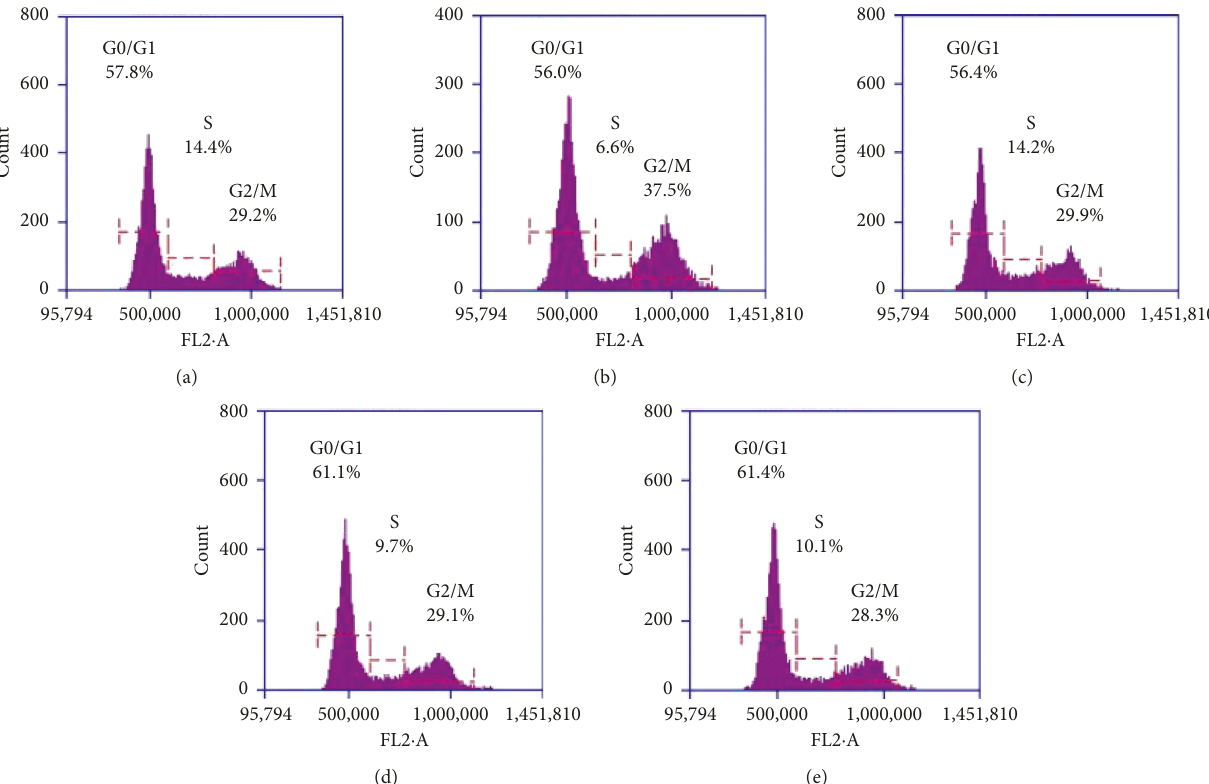
Figure 5: Effect of various compounds on different phases of HCT116 cells was estimated using flow cytometer. Histogram plots display the different phases of the cell cycle and the percentage of cells in each phase. (a) Normal control; (b) SAHA (5 μ M); (c) quercetin (100 μ M); (d) QMJ-2 (100 μ M); (e) QMJ-5 (50 μ M). Table 4: Effect of various treatments on the ACF count and ad- enocarcinoma incidence in colon tissue. Sl. no.